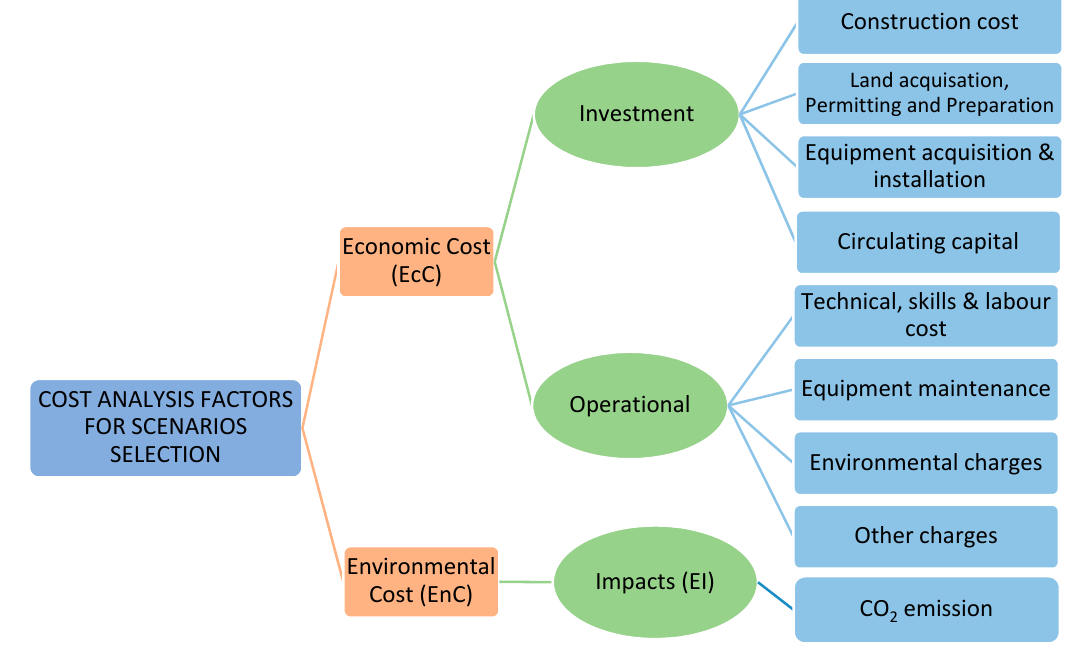
Figure 1. Ideal factors for scenarios selection.